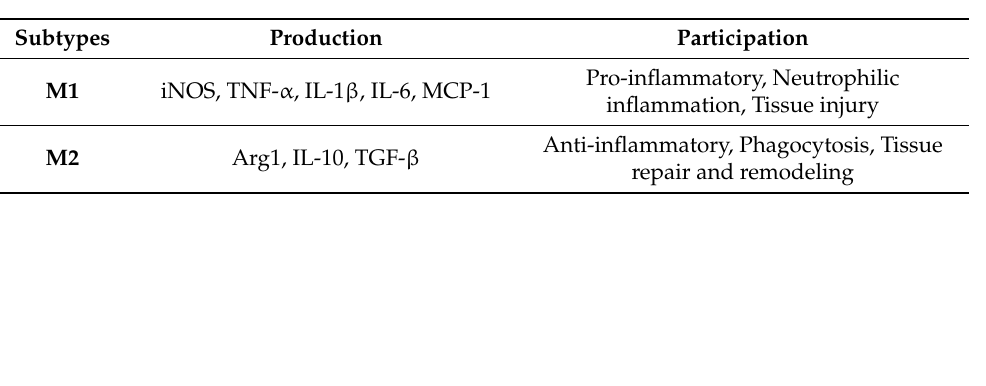
Figure 1. The macrophage population in the lung. Alveolar macrophages (AMs) and interstitial macrophages (IMs) reside in the lungs. AMs are in close contact with the epithelial cells of alveoli, and IMs reside in the parenchyma between the microvascular endothelium and alveolar epithelium. When AMs are damaged, circulating monocytes in the capillaries are then recruited to the lungs and transformed into AM-like cells. Table 1. The type of macrophages and their role in ALI/ARDS.